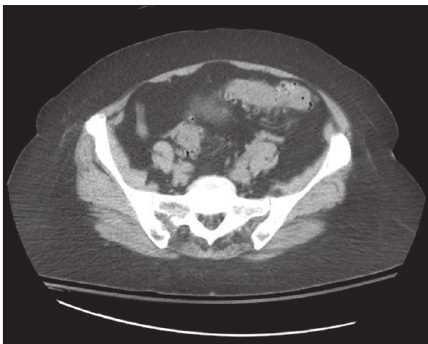
Figure 1: CT abdomen and pelvis without contrast, showing mild inflammation surrounding the sigmoid colon. Diverticulosis is present.